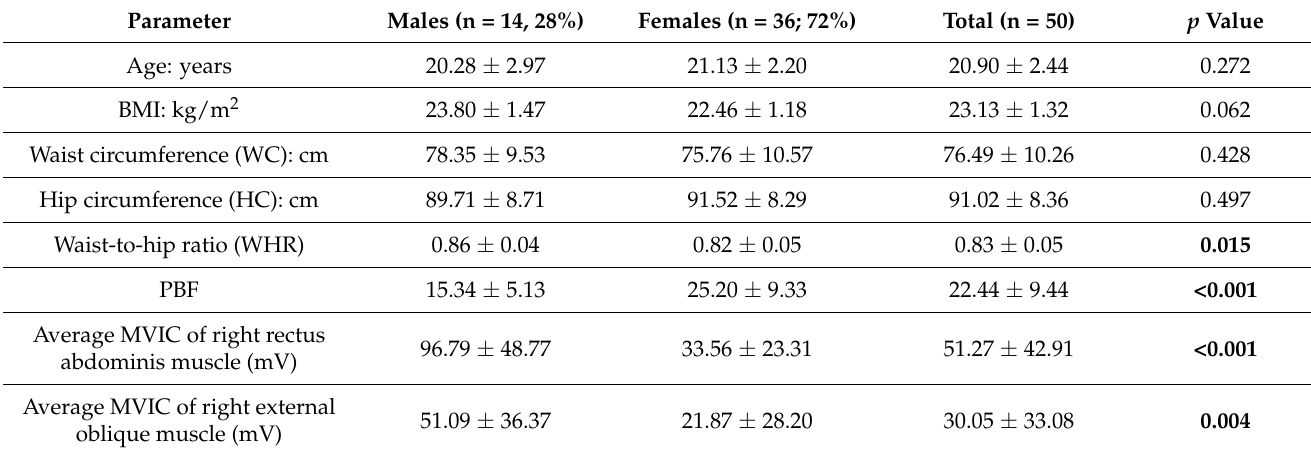
Table 1. Demographic characteristics (mean ± SD) and gender-based differences in PBF, WC, WHR and average MVIC of right RA and EO muscles among the participants (n =